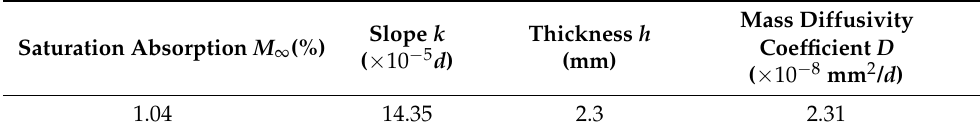
Table 3. Parameters of water absorption behaviour for the application of Fick’s law.